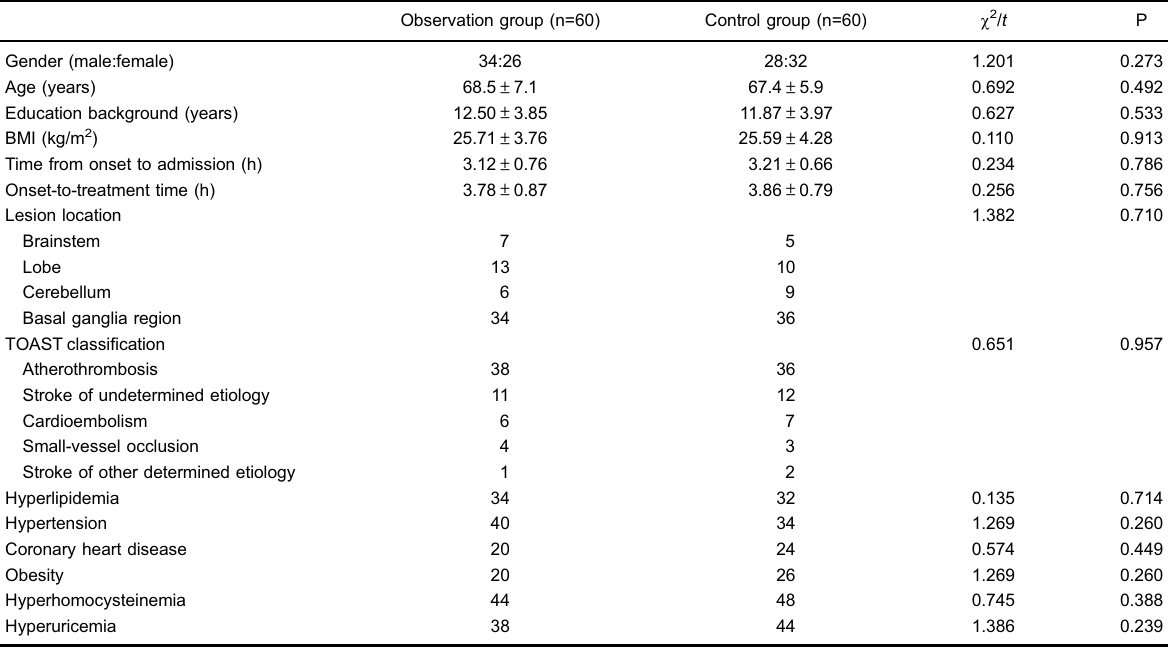
Data are reported as means ± SD or number. BMI: body mass index.